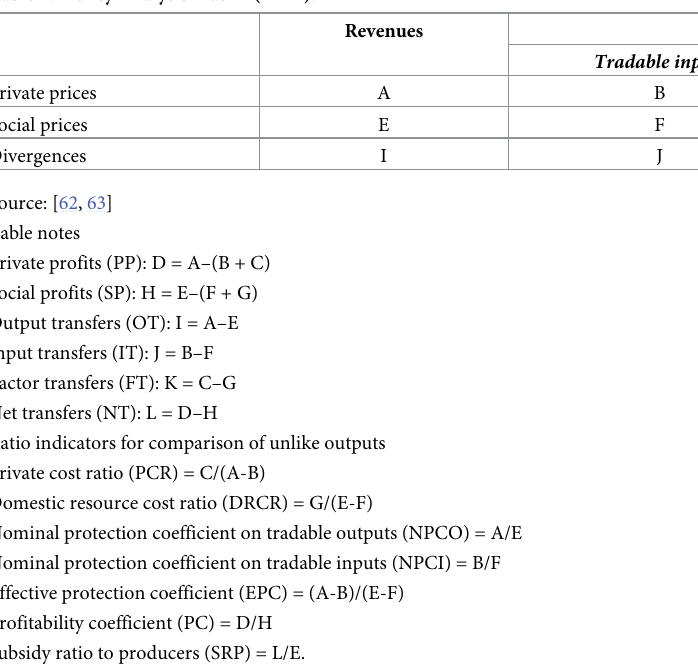
Table 1. Policy Analysis Matrix (PAM).